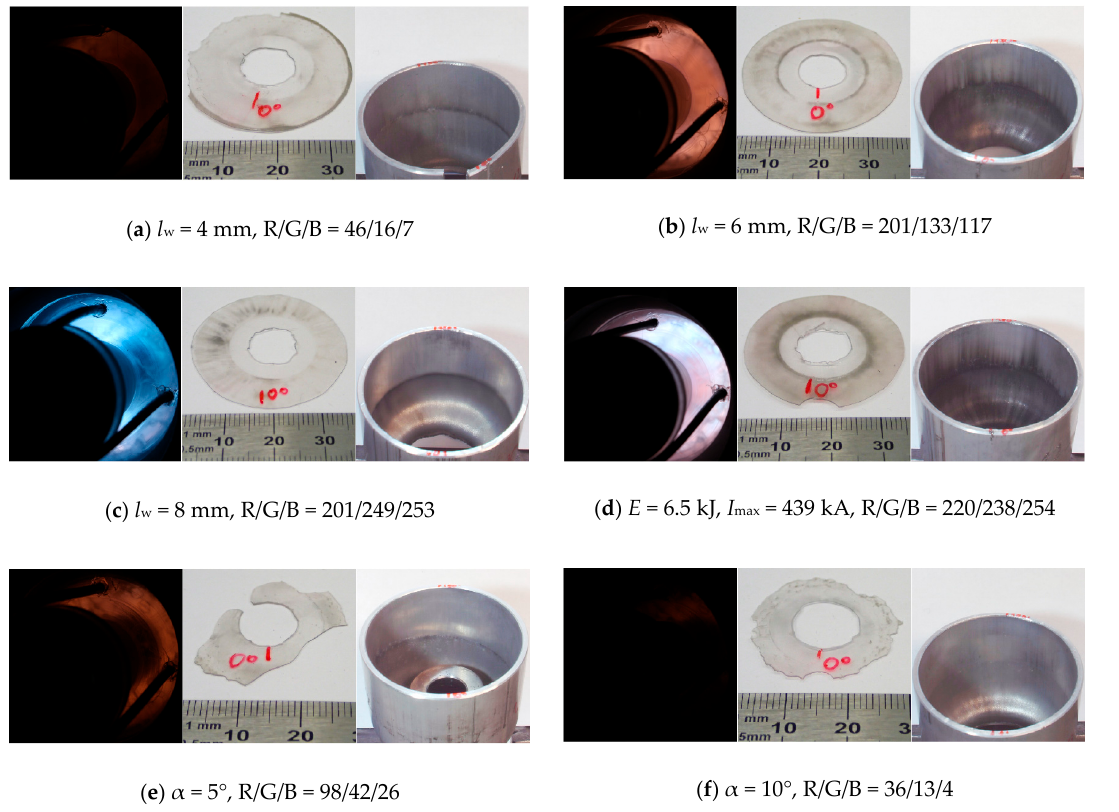
Figure 14. Long time exposures of the process glare, first plastic disc and flyer tube after MPW experiments at the Bmax setup (basic parameters: l c = 3 mm, α = 0° , g = 1.5 mm, E = 4.5 kJ, I max = 365 kA, Ø coil = 41 mm, w c = 10 mm, l w = 6 mm): ( a – c ) for different working length l w , ( d ) charging energy, and ( e , f ) parent angles α .